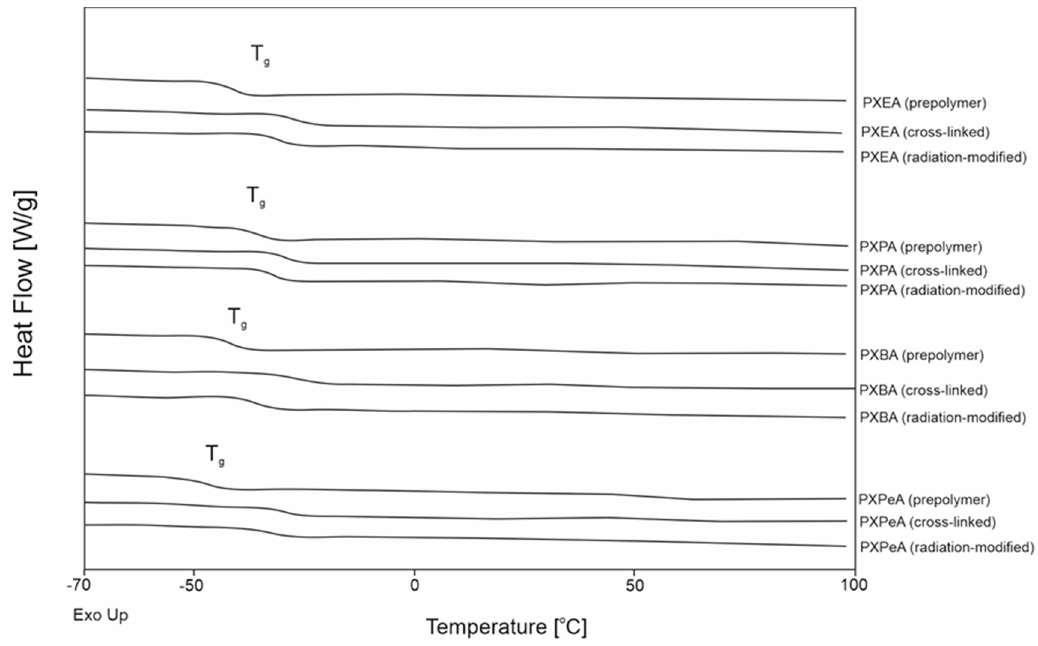
Figure 9. Differential scanning calorimetry (DSC) thermograms for first-heating of PXEA, PXPA, PXBA, and PXPeA prepolymers and polymer crosslinked and polymer after radiation modified.